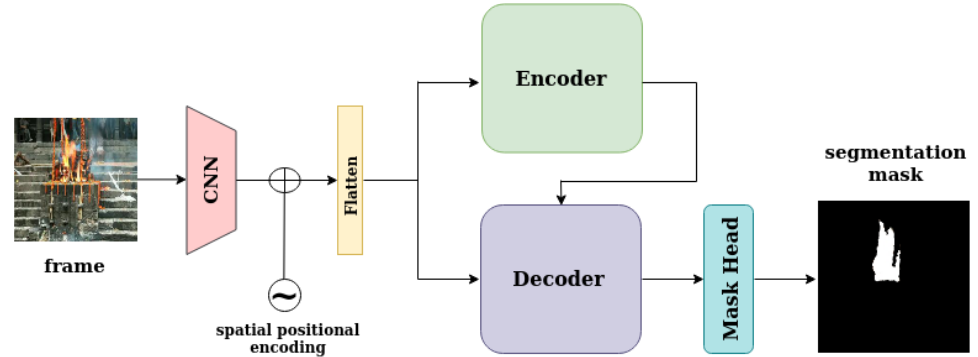
Figure 1. This figure depicts model architecture for the in-frame fire localization task. Both the encoder and the decoder consume the current frame that is under examination and output attention scores. These attention scores pass through the mask head in order to produce segmentation mask that localizes fire in the image